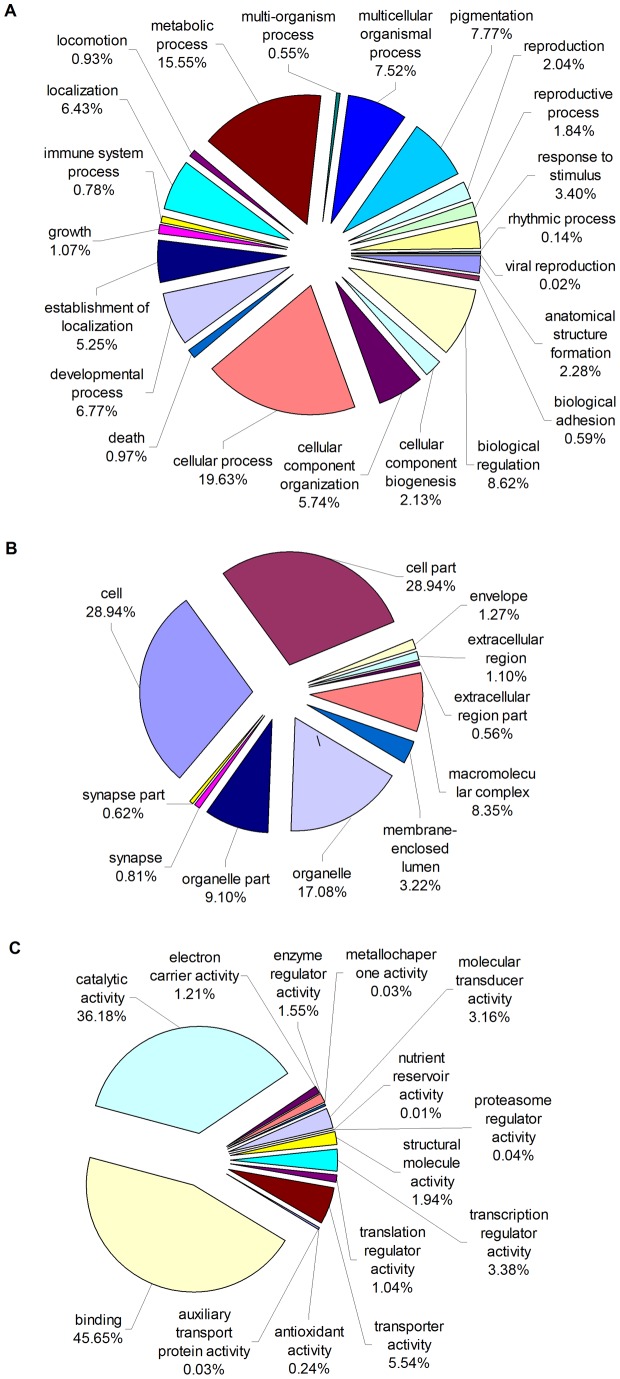
Gene ontology (GO) classification of Tenebrio molitor unigenes.Categories for (A) biological processes, (B) cellular components, and (C) molecular processes. The data presented represent the level 2 analysis. The percentage of a specific category of genes in that main category is shown.